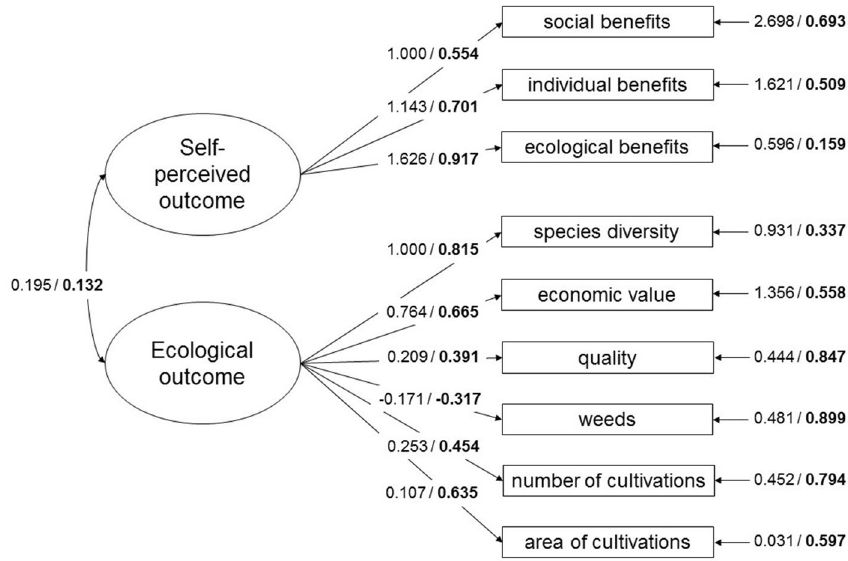
Figure 3. The model for ecological and self-perceived outcome –latent variables and their reflective indicators in an urban gardening system. The covariance between the latent variables, factor loadings for each reflective indicator (all significant) and error terms for the reflective indicators are presented (unstandardized estimates / standardized estimates bolded) (see Table S5 online for p-values and standard errors for each estimate). The error terms for the reflective indicators are shown after the arrows pointing to the indicators and they signify the variance not explained by the respective latent variable they are loading